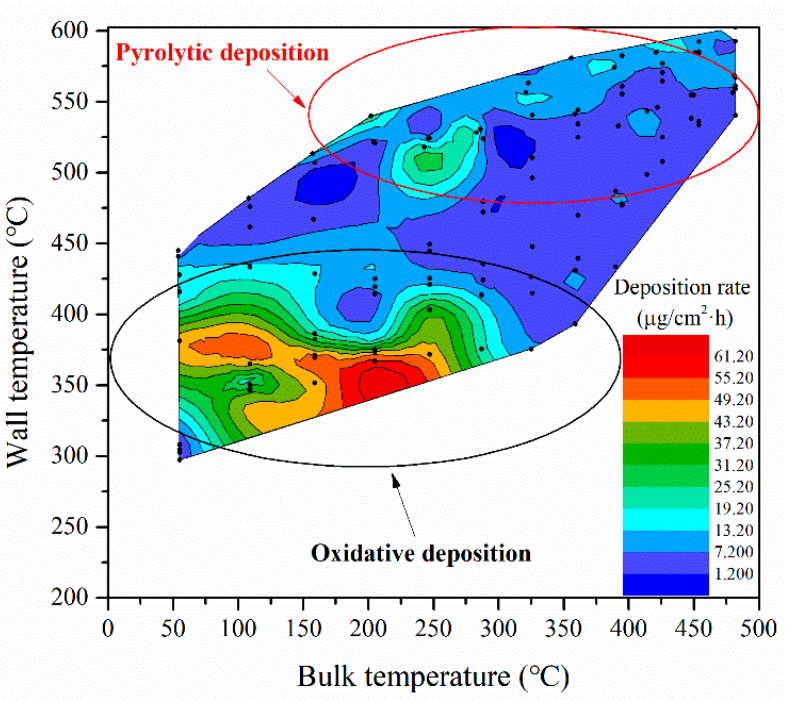
Figure 16. Dependence of the surface deposition rate on bulk and wall temperatures for all experi- ment cases.